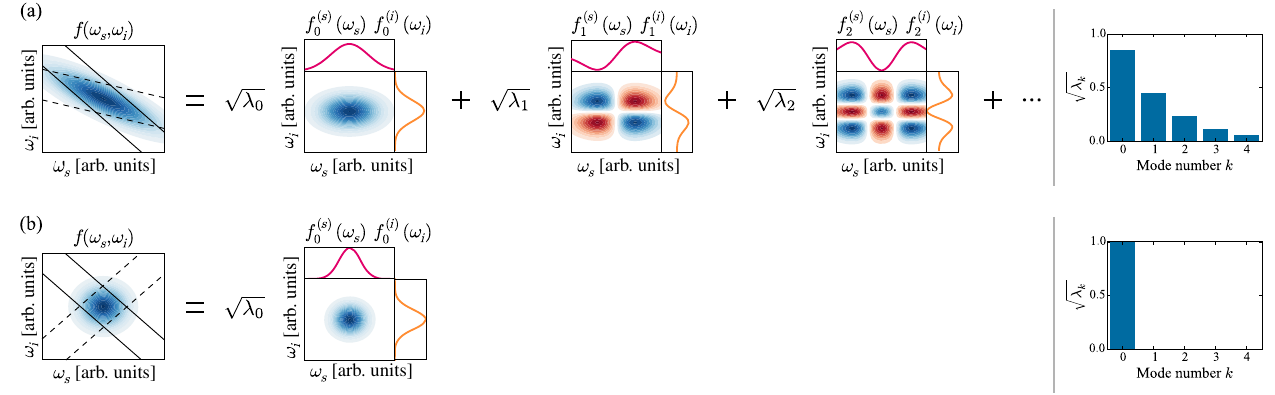
; ω , which is the product of pump s i Þ ffiffiffiffiffi p λ consequently exhibits k